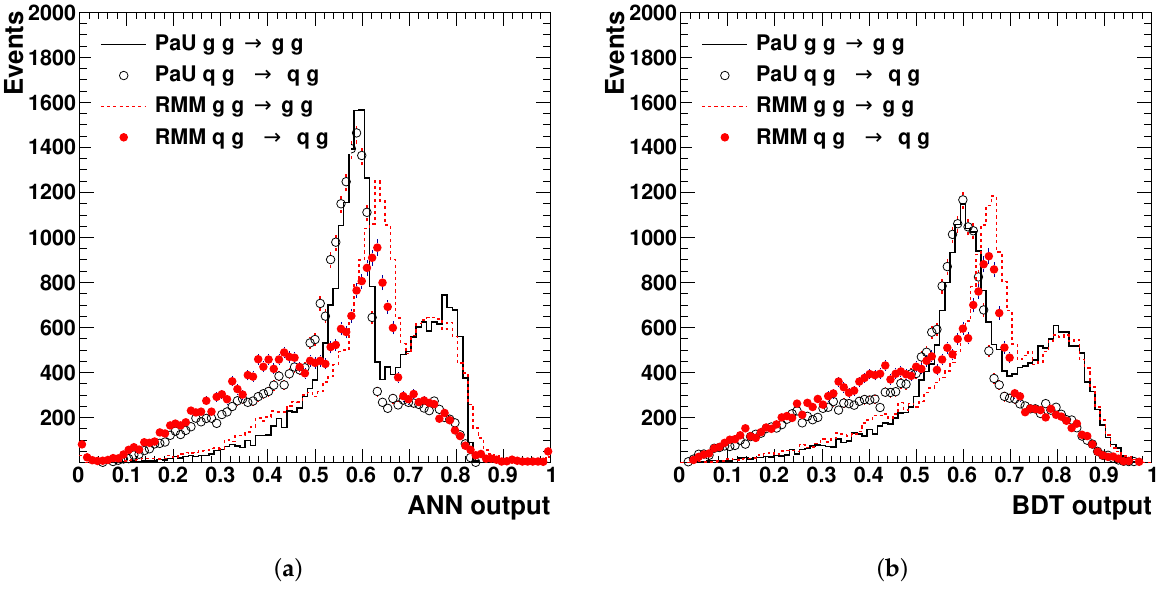
Figure 8. ( a ) The ANN output for gg and qg events in the case of a “pick-and-use“ (PaU) approach based on seven selected input variables and the RMM. ( b ) The output of the boosted decision tree (BDT) for the same inputs as in ( a ). The events were generated using Pythia8 after parton showers followed by